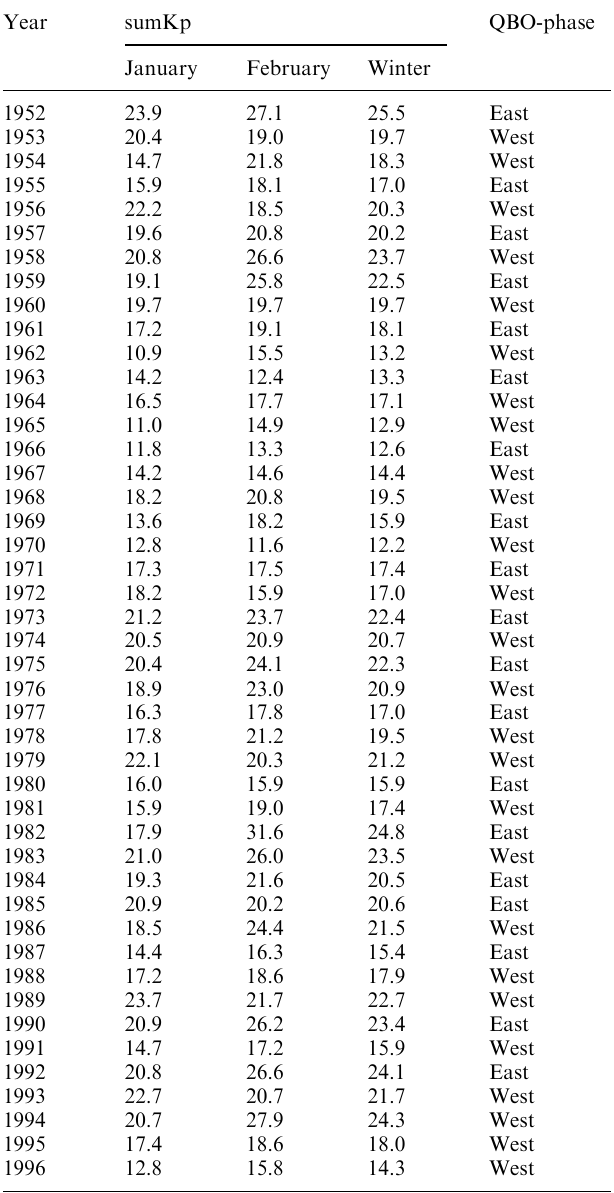
Table 1. The mean values of geomagnetic activity sum Kp for January, February and winter (January–February), and phase of the quasi-biennial oscillation (QBO)